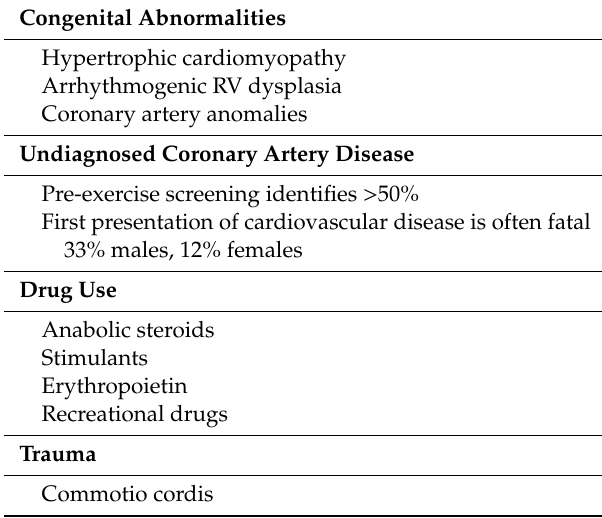
Table 1. Negative outcomes during exercise